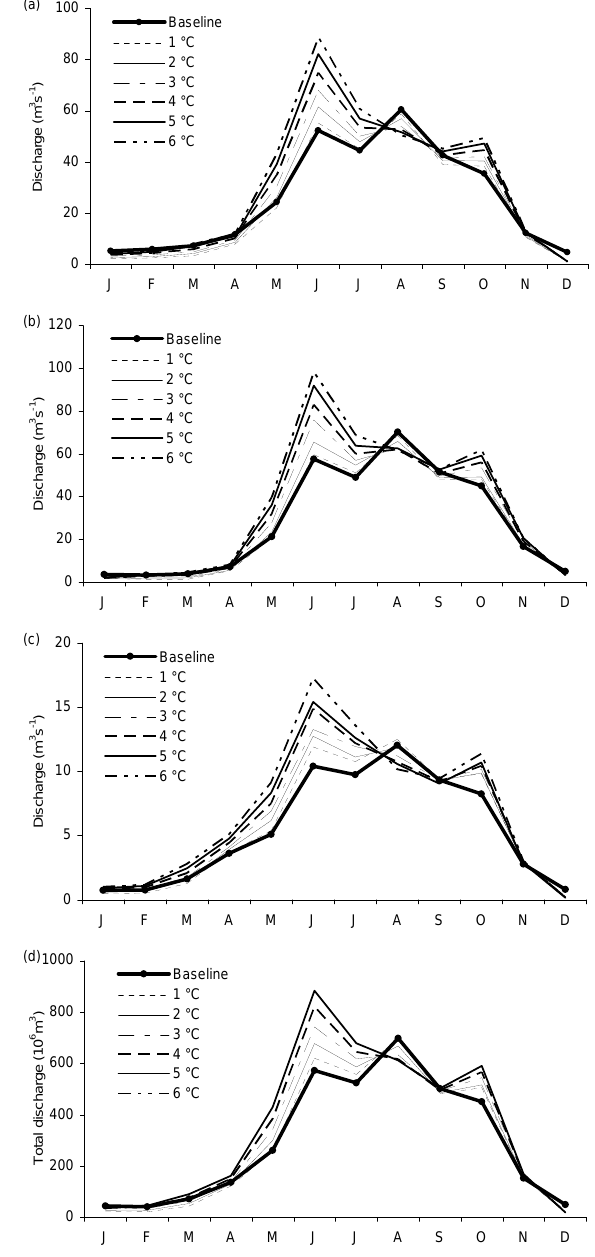
Fig. 6. Mean monthly discharge for the Group 1 scenarios (a) Thoubal, (b) Iril, (c) Nambul, (d) total river inflow to Loktak Lake.